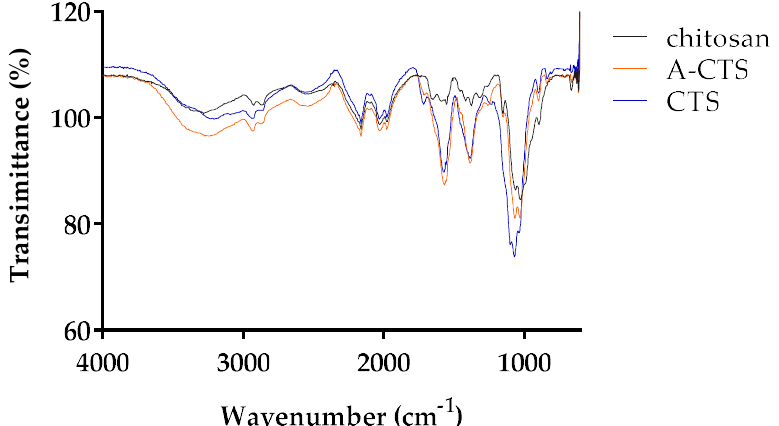
Figure 1. Comparison of FTIR spectra of Chitosan, A-CTS, and CTS. FTIR spectra were obtained from scans from 4000 to 600 cm −1 .